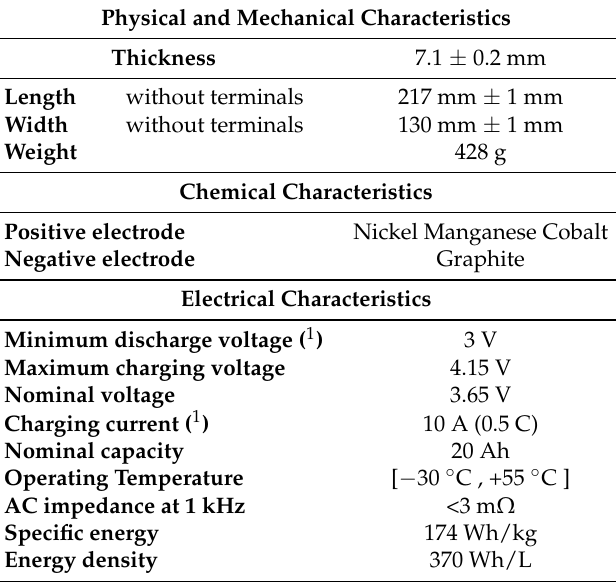
Table 1. Main properties of the high energy lithium polymer EIG C020 battery cells